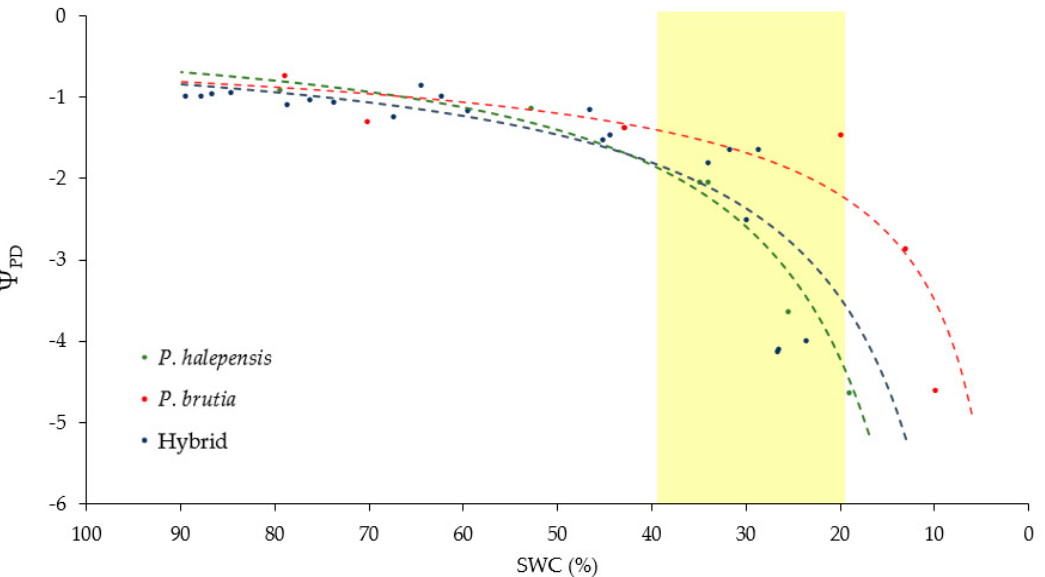
Figure 2. The relationship between soil water content (SWC) and plant predawn leaf water potential ( Ψ PD ). The yellow region marks the range in which the plants started to reduce their leaf water potential. Each dot on the graph is an average of measurement of three different branches.